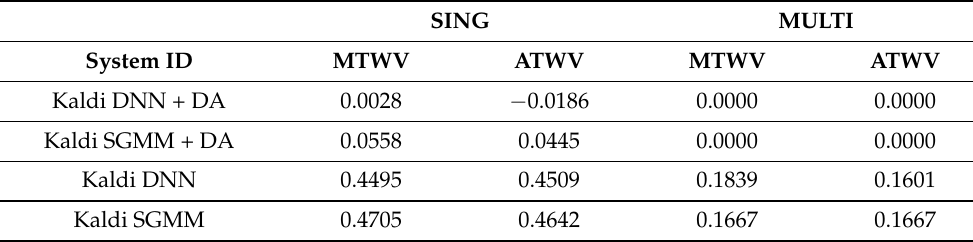
Table 21. System results of the STD task for MAVIR test data for single-word (SING) and multi-word (MULTI) queries.